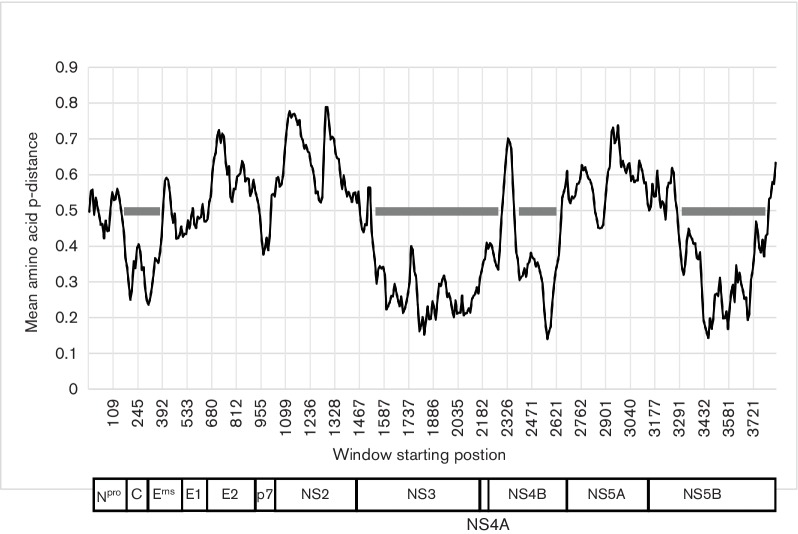
Amino acid sequence diversity across pestivirus genomes. Mean amino acid
p-distances were computed for a sliding window of 50 amino acids shifted by
10 residues across the complete coding region for comparisons between single
representatives of each accepted and proposed Pestivirus
species. Positions are numbered relative to the polyprotein of BVDV-1 SD-1
(M96751). Intervals on the x-axis are not regular because of un-numbered
alignment gaps. Four regions where mean distances are consistently <0.5
are indicated by grey bars. A schema of the proteins encoded by the virus
genome is provided below.